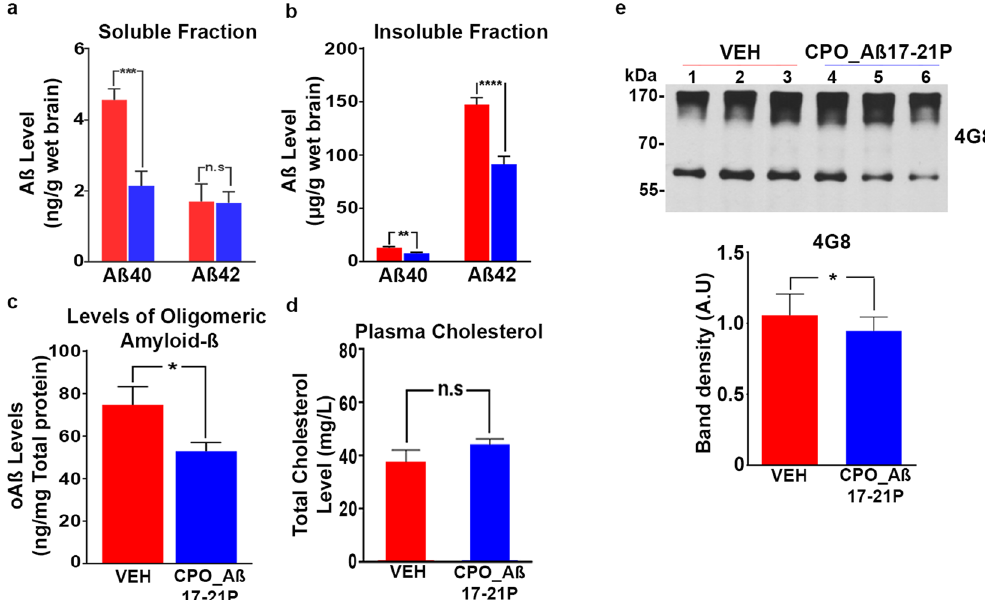
Figure 4. Reduction of soluble and insoluble Amyloid- β levels on APP/PS1 mice treated with peptoid CPO_ A β 17-21 P. ( a ) Reduction of A β 40 in the soluble fraction extracted with diethylamine (DEA) from APP/PS1 mice brain homogenates ( *** p < 0.001, two-tailed unpaired t-test). ( b ) Reduction of A β 40 and A β 42 levels in the insoluble fraction extracted with formic acid (FA) ( *** p < 0.001 and **** p < 0.0001 respectively, two-tailed unpaired t-test). ( c ) Reduction of A β oligomeric species measured by ELISA assay ( * p < 0.05, two- tailed unpaired t-test). ( d ) Plasma cholesterol levels on APP/PS1 mice treated with peptoid CPO_ A β 17-21 P ( p > 0.05, two-tailed unpaired t -test). ( e ) Reduction of A β oligomeric species shown by western blot with anti- amyloid antibody 4G8 on APP/PS1 mice brain homogenates ( * p < 0.05, two-tailed unpaired t